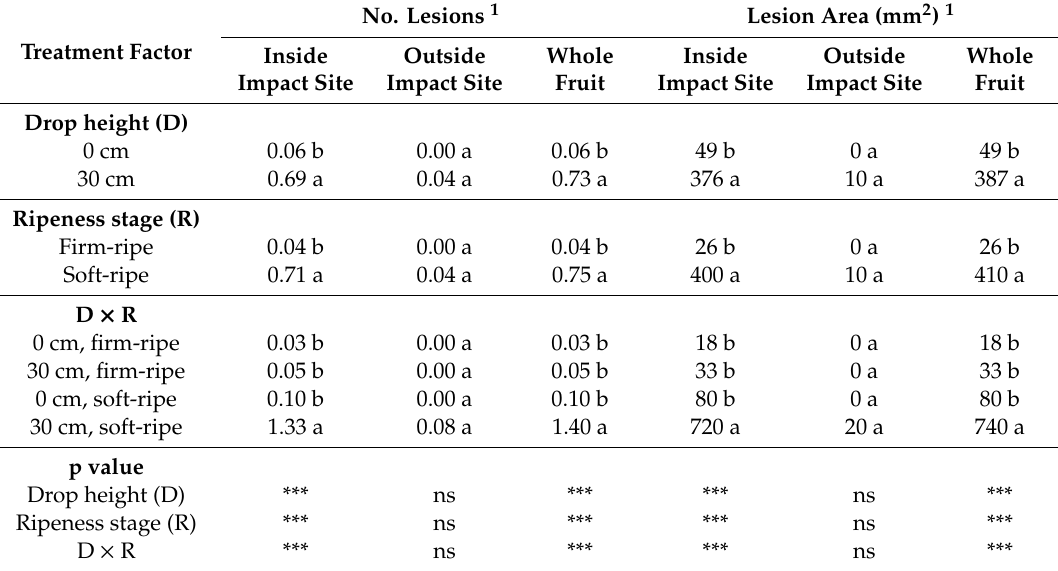
Table 5. Lesion number and lesion area inside the impact site, outside the impact site and for the whole fruit in 2016 season ‘Hass’ avocado fruit dropped from 0 or 30 cm on the day of harvest in Experiment 3 and assessed at firm-ripe or soft-ripe